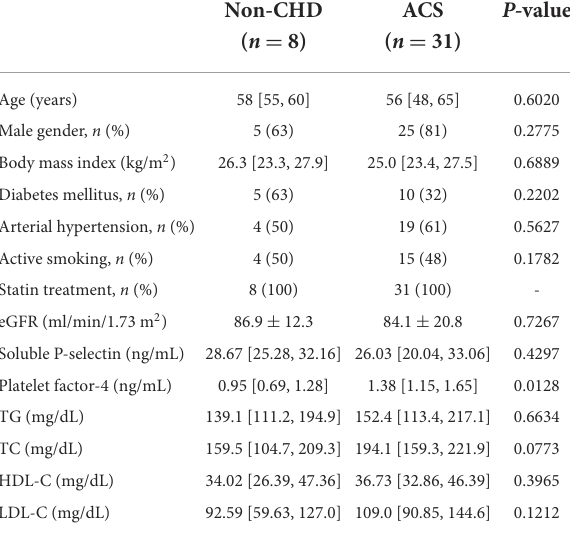
TABLE 1 Baseline characteristics in patients with non-CHD and